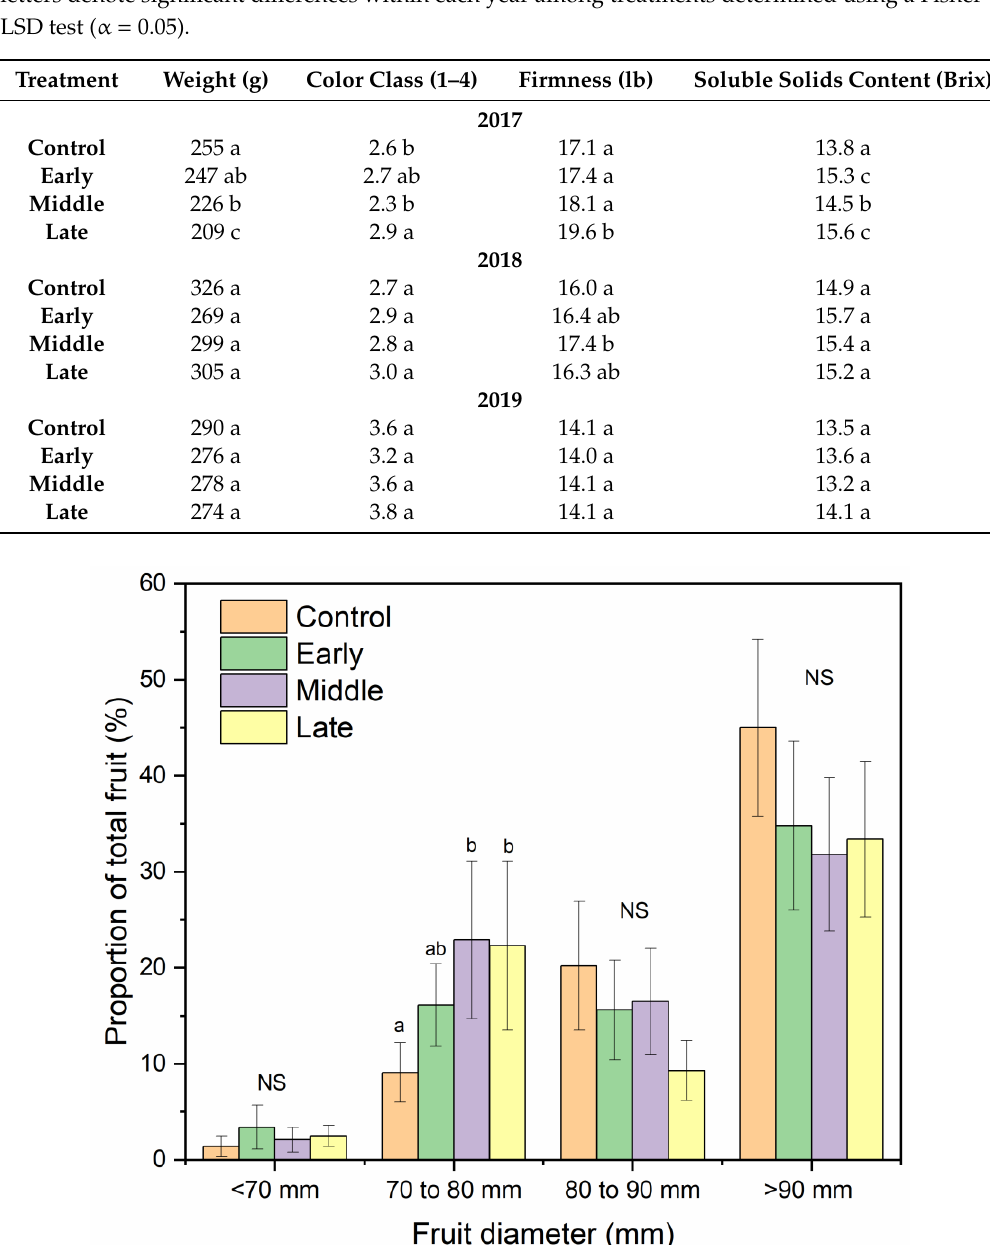
Figure 7. Percentage of Honeycrisp fruit belonging to each size category ( < 70 mm, 70–80 mm, 80–90 mm, and > 90 mm diameter) for trees where early, middle, and late season water deficits were applied compared to a well-watered control from 2017 to 2019. NS = not significant among treatments within each size category. Letters denote significant di ff erence among treatments determined using a Fisher’s LSD test ( α =